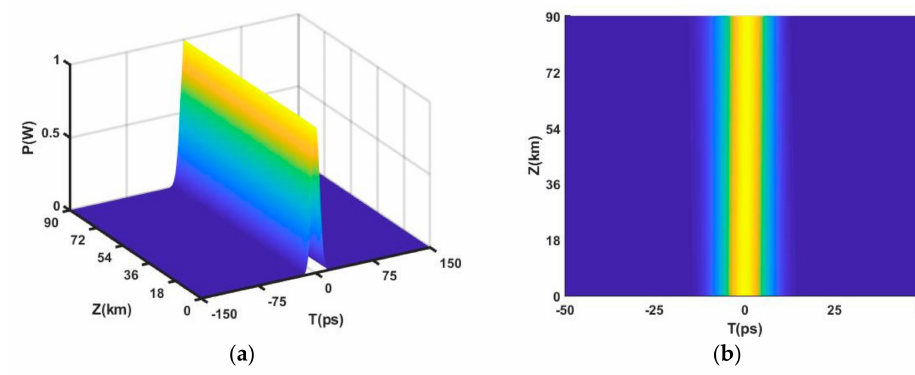
Figure 9. ( a ) Gaussian pulse’s 90 km propagation; ( b ) top view of ( a